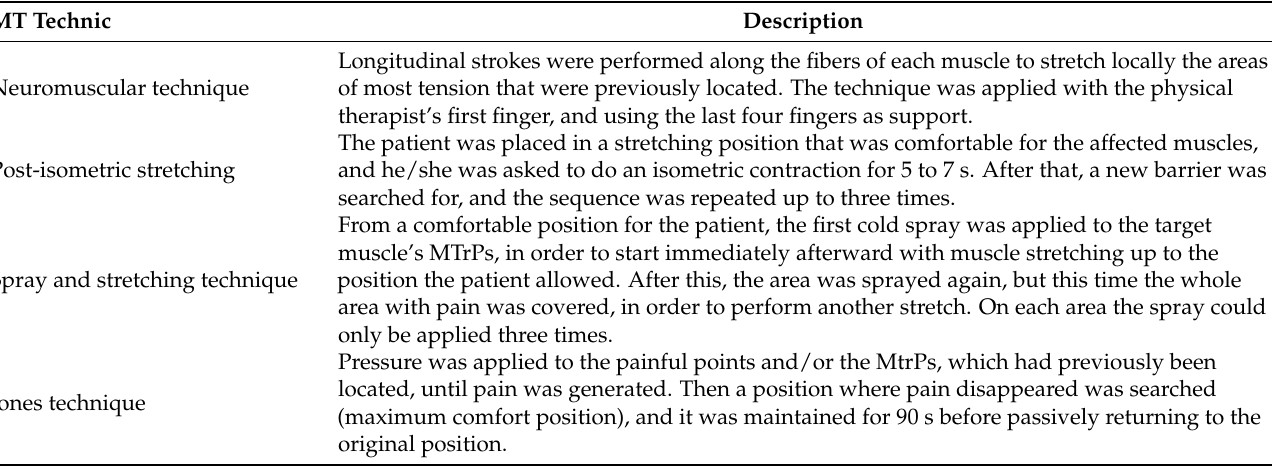
Table 1. Description of Manual Therapy Technics